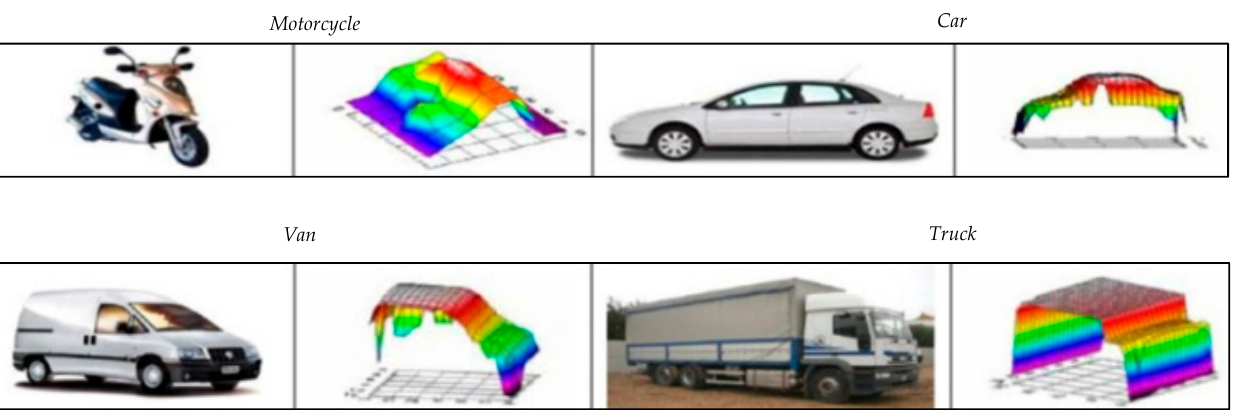
Figure 12. Some 3D profiles extracted from different vehicles.